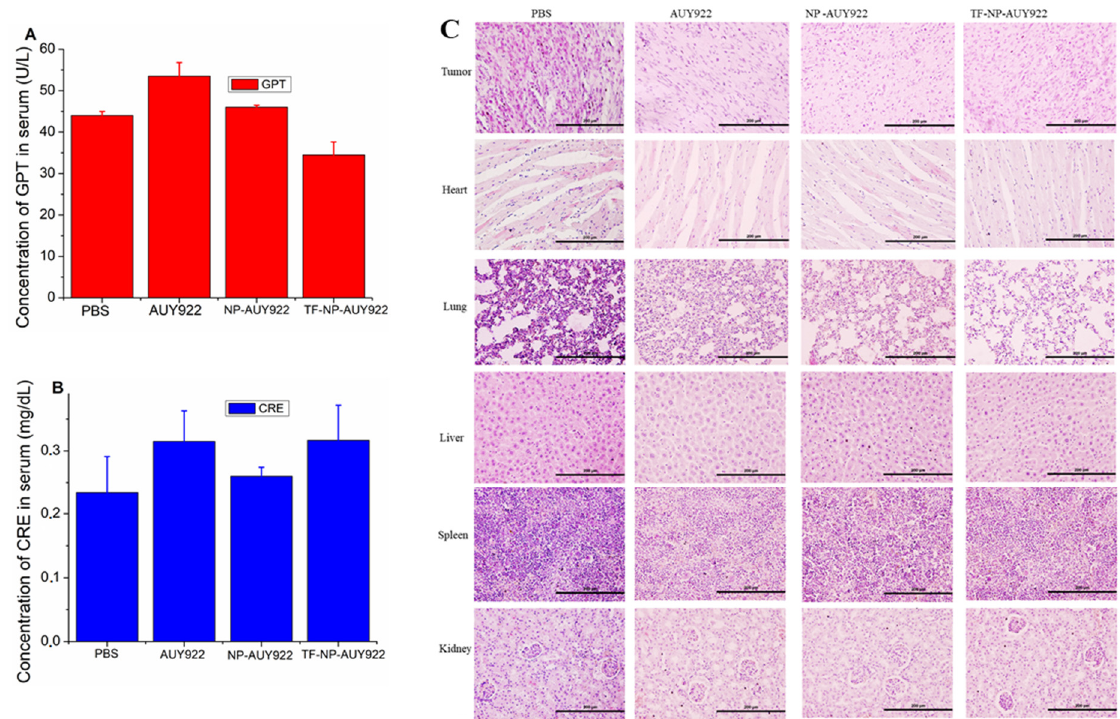
Figure 10. Toxicity evaluation of free AUY922, NP-AUY922, and TF-NP-AUY922 in comparison to control groups after 14 days of injections ( A ) Liver function test, ( B ) Kidney function test, ( C ) H&E staining. Scale bar represents 200 µ m and magnification 20×.